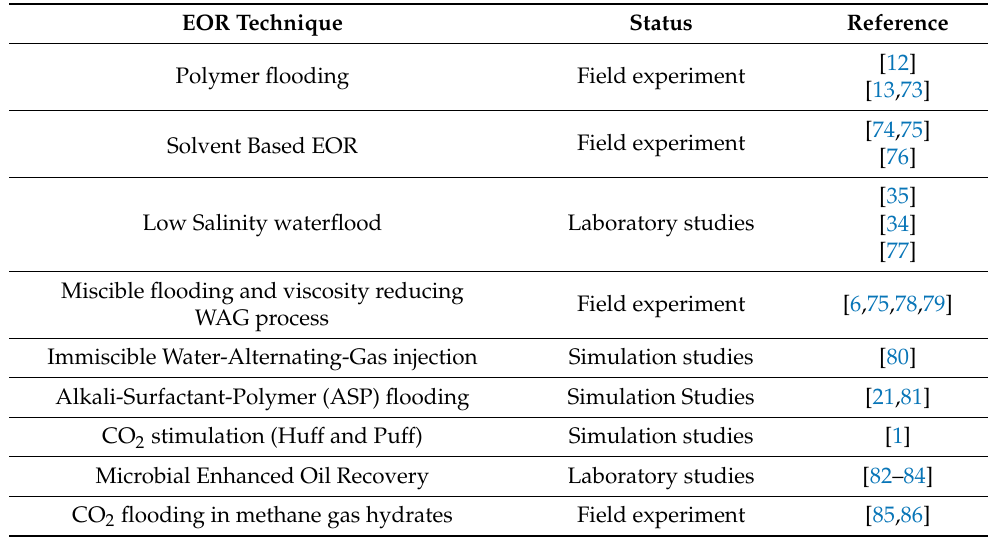
Table 2. An Overview of EOR Techniques Studied and Employed in